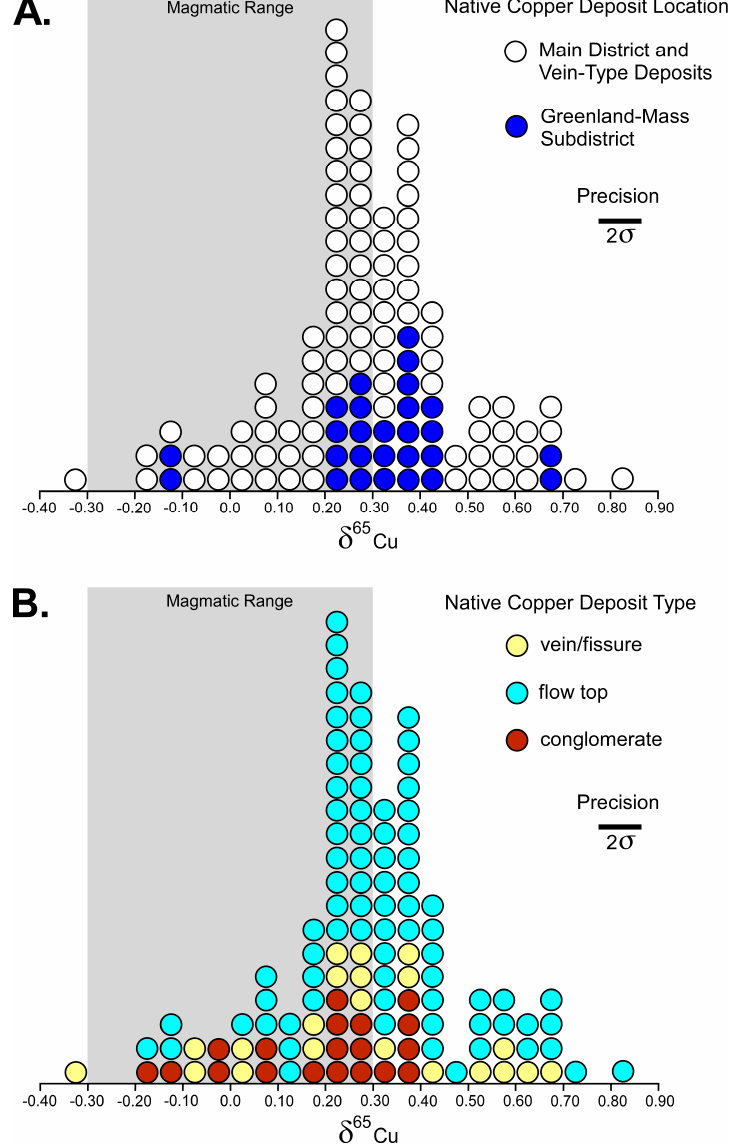
Figure 4. Dot histogram of the copper isotopic composition of native copper from the Keweenaw Peninsula, Michigan. ( A ) The main district and vein-type deposits to the northeast are compared to deposits of the Greenland-Mass subdistrict. ( B ) The major native copper deposit types are compared to each other. Copper isotopic data are given in Table 2.